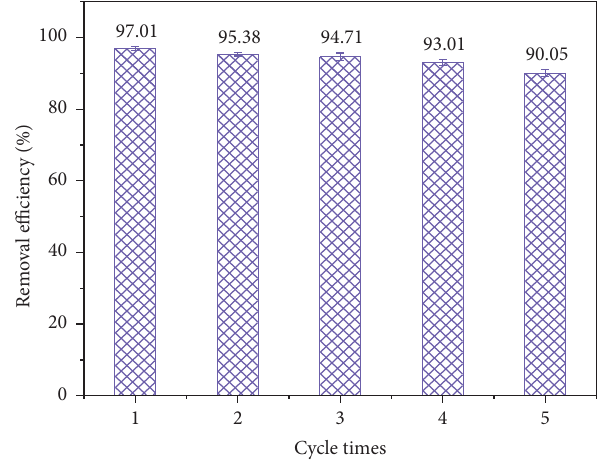
Figure 6: Isothermal adsorption